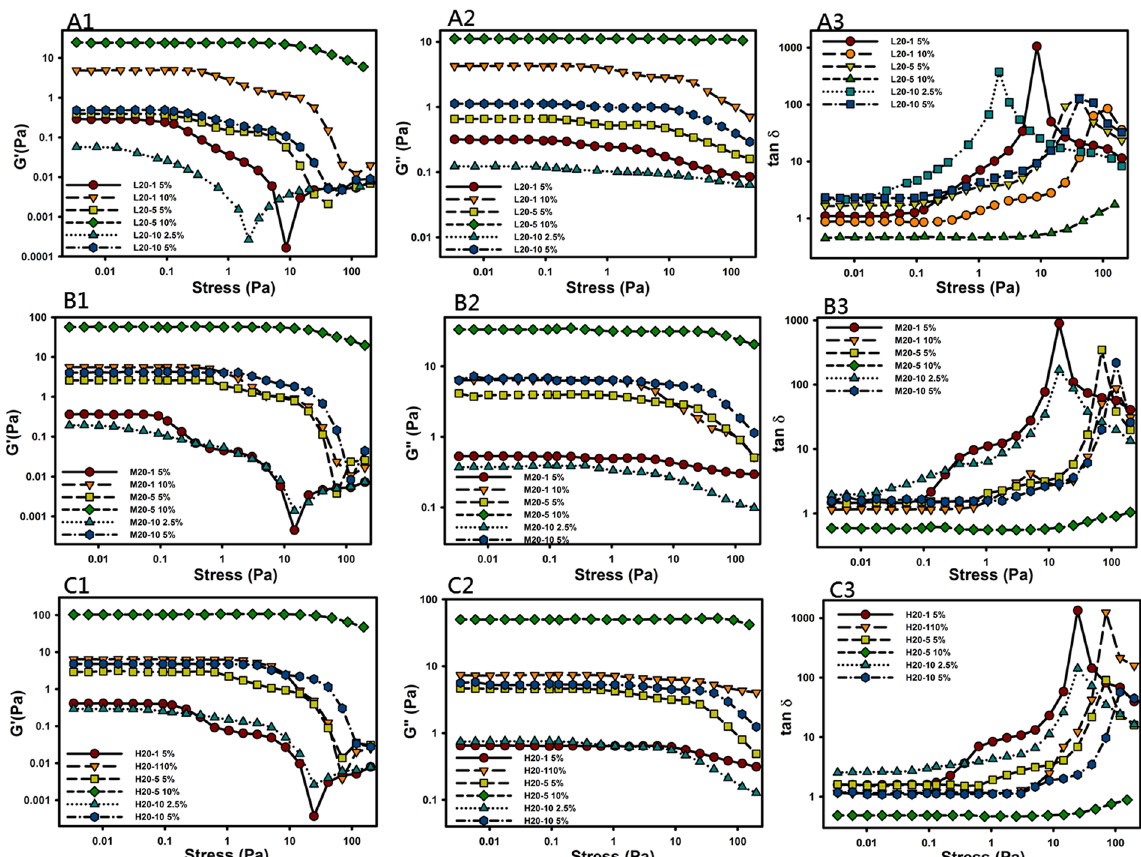
Figure 1. Comparison of the amplitude sweeps of ring-opened polyvinyl pyrrolidone ( ro PVP)/chitosan (CS) hydrogels composed of various ratios (20:1, 20:5, and 20:10) of ro PVP/CS and different molecular weights (Mws) of CS (L, low Mw; M, medium Mw; and H, high Mw). ( A1 ) L20-1; ( A2 ) L20-5; ( A3 ) L20-10; ( B1 ) M20-1; ( B2 ) M20-5; ( B3 ) M20-10; ( C1 ) H20-1; ( C2 ) H20-5; ( C3 )